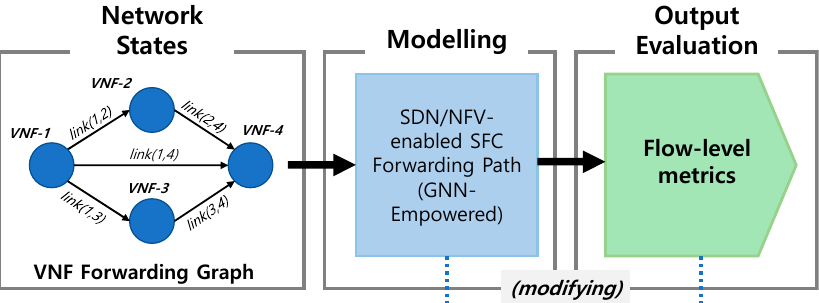
Figure 3. GNN-empowered SFC forwarding path with graph-structured nodes and virtual links.